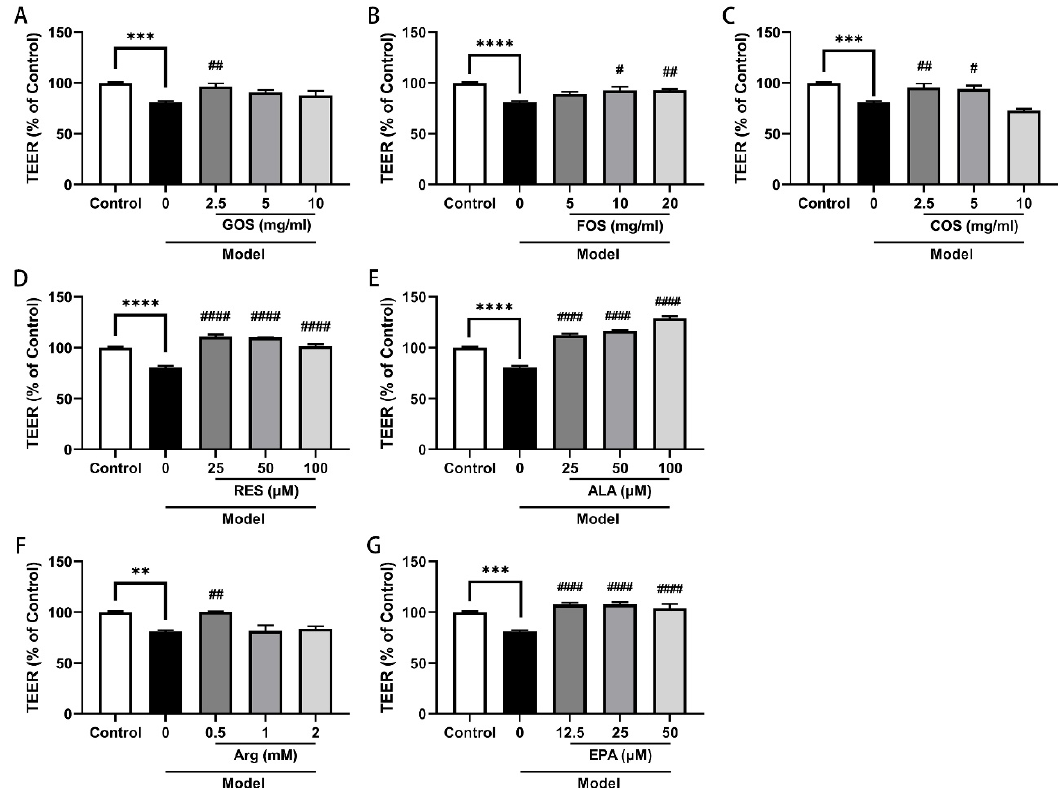
Figure 2. Relative TEER values of Caco ‐ 2/HT ‐ 29 cell monolayers pre ‐ incubated with GOS ( A ), FOS ( B ), COS ( C ), RES ( D ), ALA ( E ), Arg ( F ), and EPA ( G ) for 48 h then exposed to hypoxia and heat treatment (2 h). After heat/hypoxia exposure, TEER values were determined by using an epithelial volt ‐ ohm meter. All values were presented as means ± SEM (N = 3, n = 3). Same control and model values were depicted in separate figures for different nutritional components. Statistical differences were analyzed by two ‐ way ANOVA followed by the Bonferroni’s multiple comparison test. ** p <